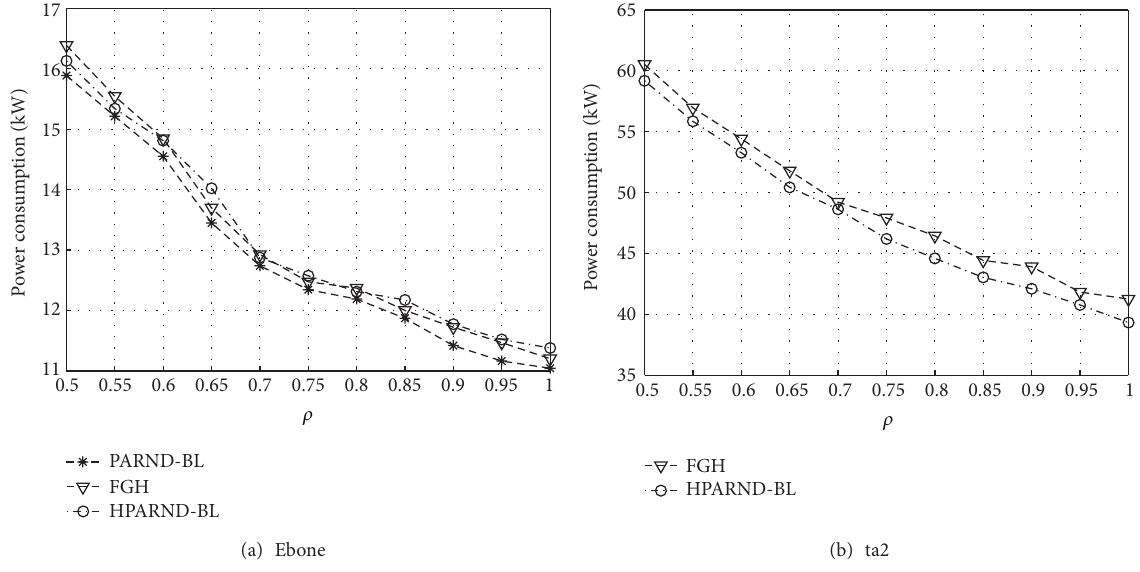
Figure 4: Power consumption versus load factor 𝛼 .